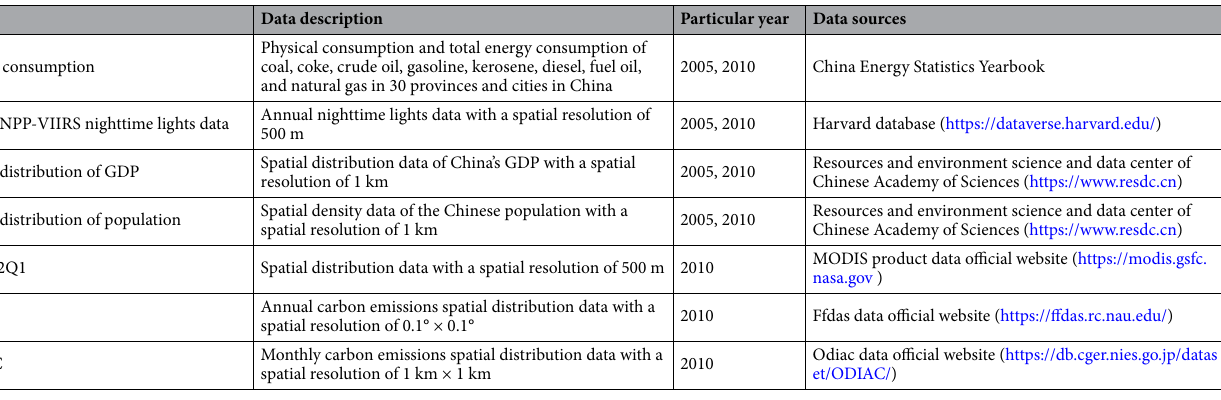
Table 2. Data description.